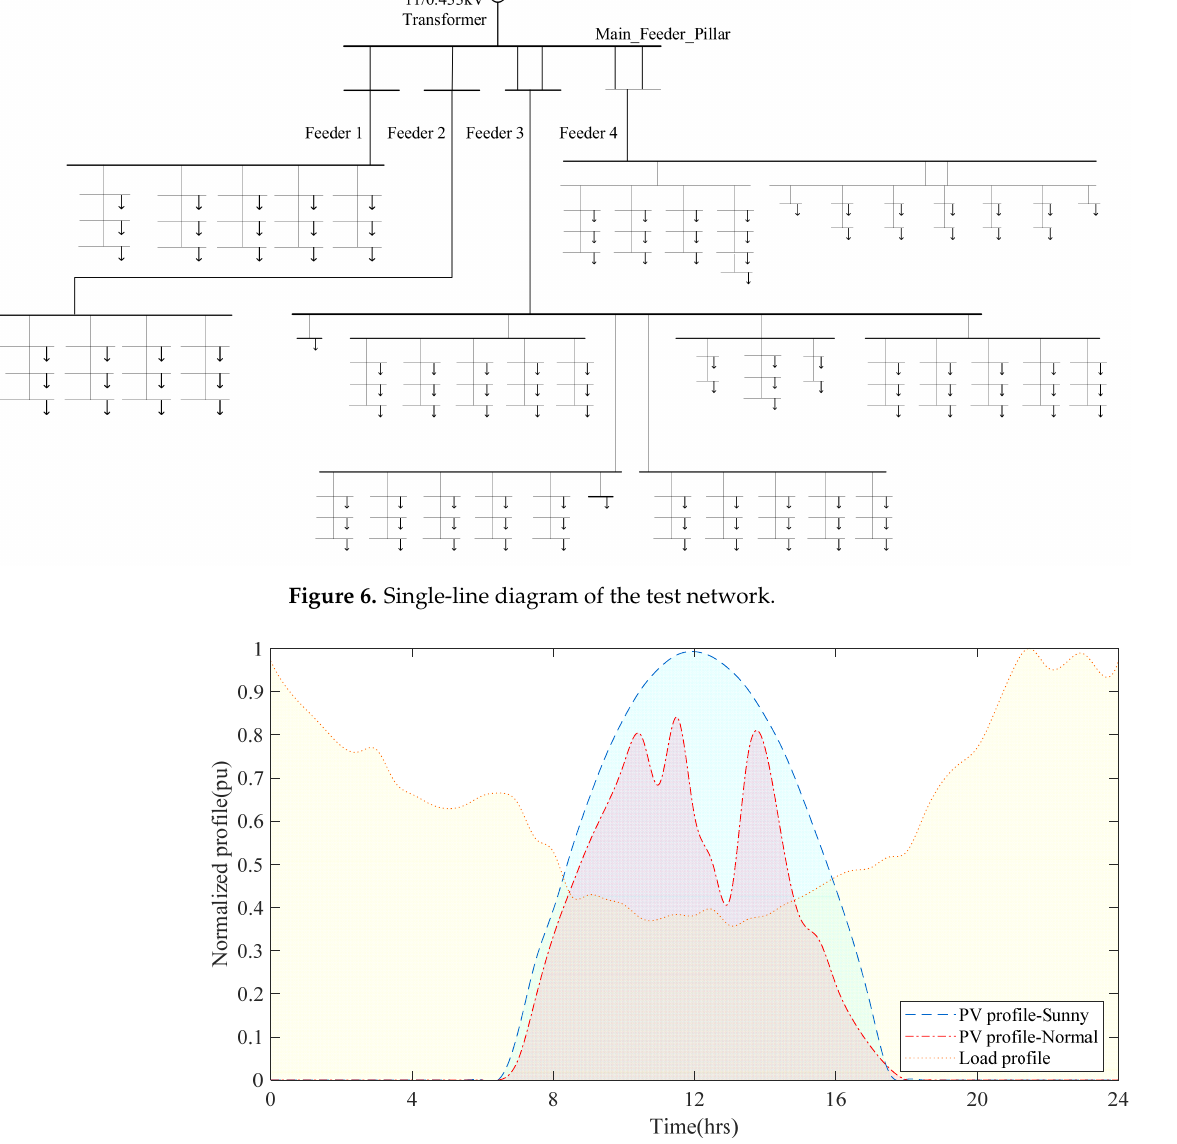
Figure 7. Normalized daily residential load and PV generation profiles.